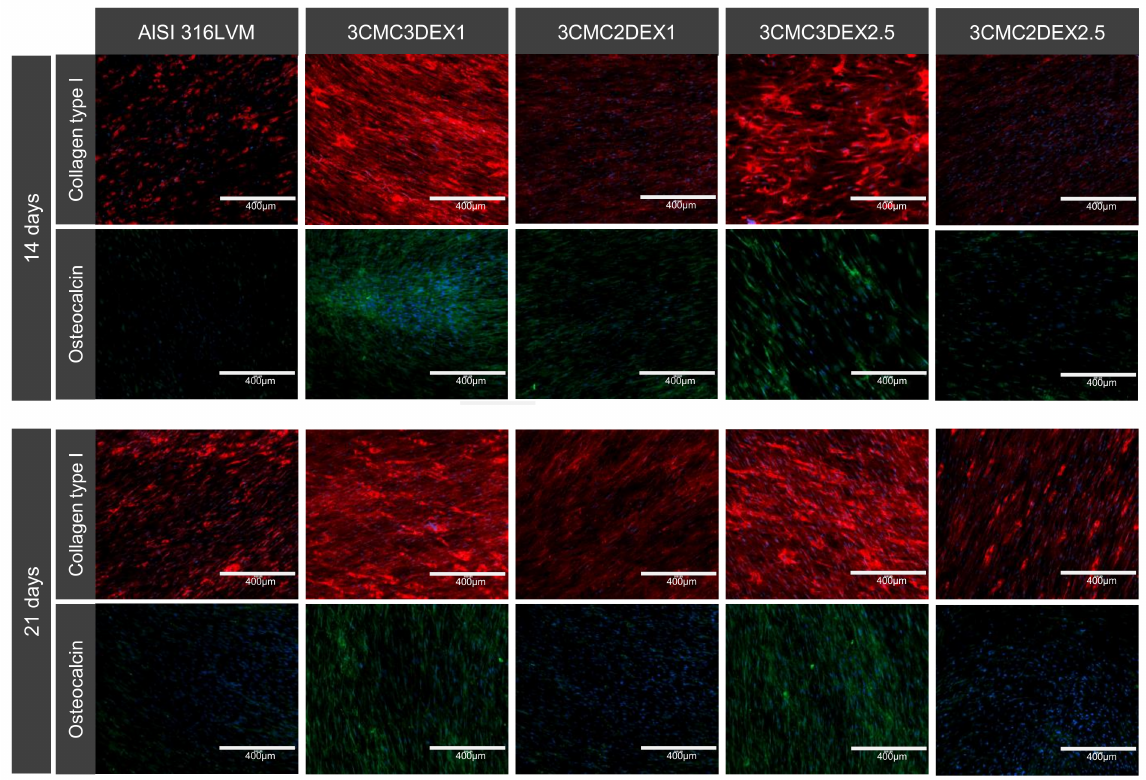
Figure 10. Dexamethasone induces osteogenic differentiation of MSCs. Cells were incubated for 14 and 21 days before immunostaining for osteo-specific markers. Red: collagen type I. Green: osteocalcin. Blue: cell nuclei